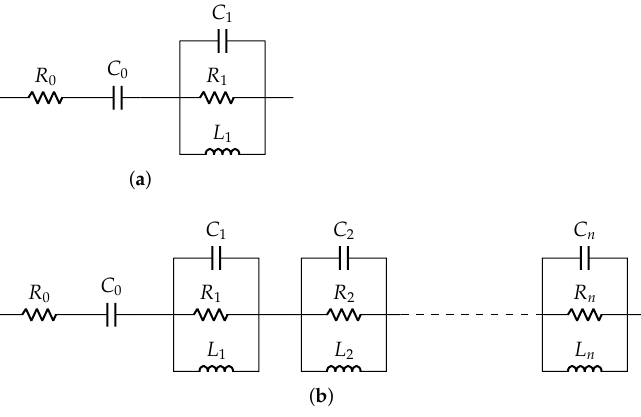
Figure 6. Easy model: ( a ) unloaded case and ( b ) loaded case.